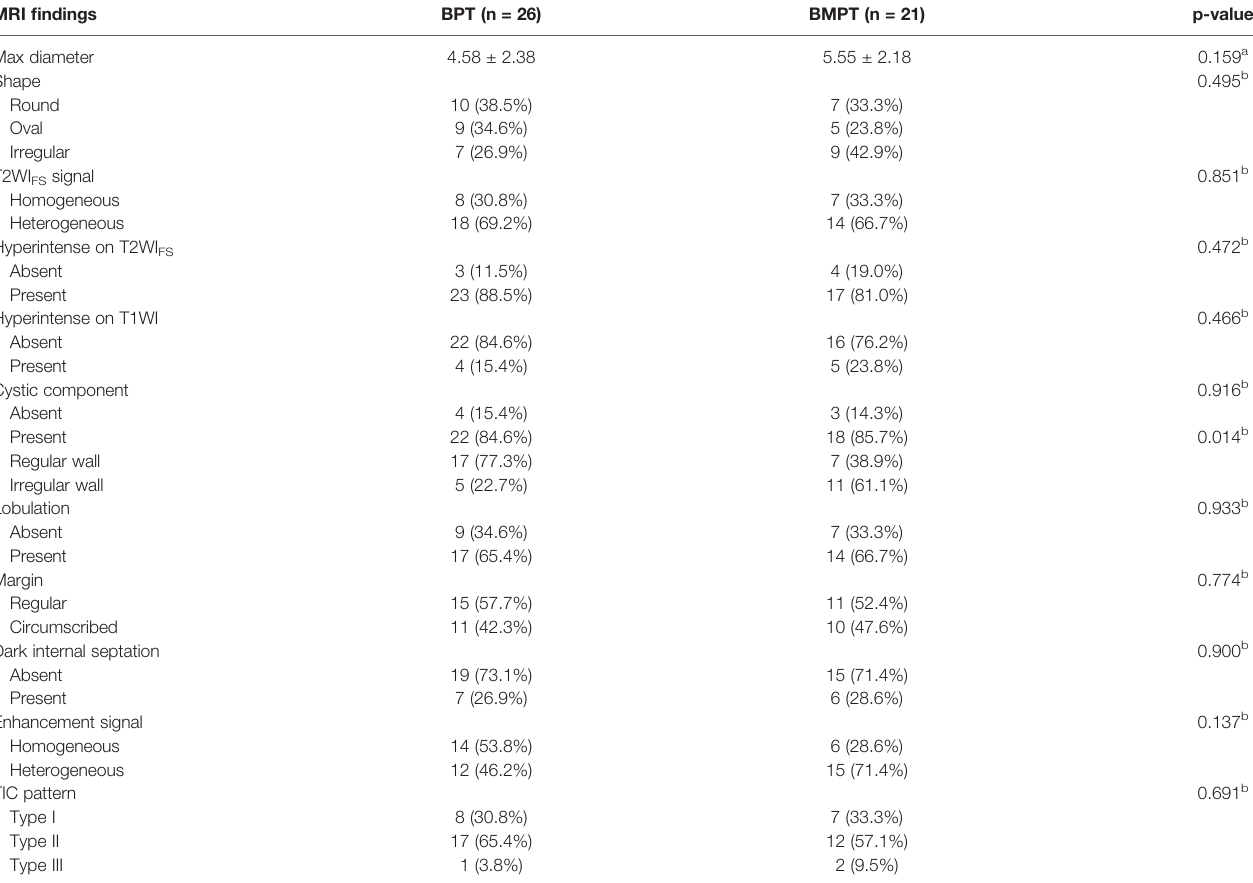
TABLE 3 | Conventional MRI fi ndings between BPT and BMPT groups.